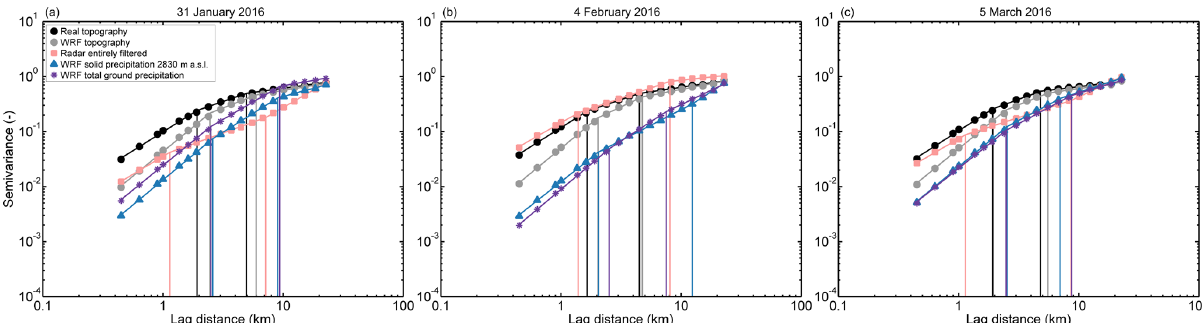
Figure 7. Normalized variograms of the snow precipitation events on (a) 31 January 2016, (b) 4 February 2016 and (c) 5 March 2016 for the regional domain (450m horizontal grid spacing, Fig. 1). Variograms are given for entirely filtered radar snow precipitation (orange), WRF snow precipitation at 2830m above sea level (ma.s.l., blue) and WRF total ground precipitation (violet). Additionally, variograms are given for real topography (based on dhm25 © 2018 swisstopo (5740000000), black) and WRF topography (gray). WRF topography and precipitation are from simulations with weak terrain smoothing (Sect. 2.1). All precipitation fields are